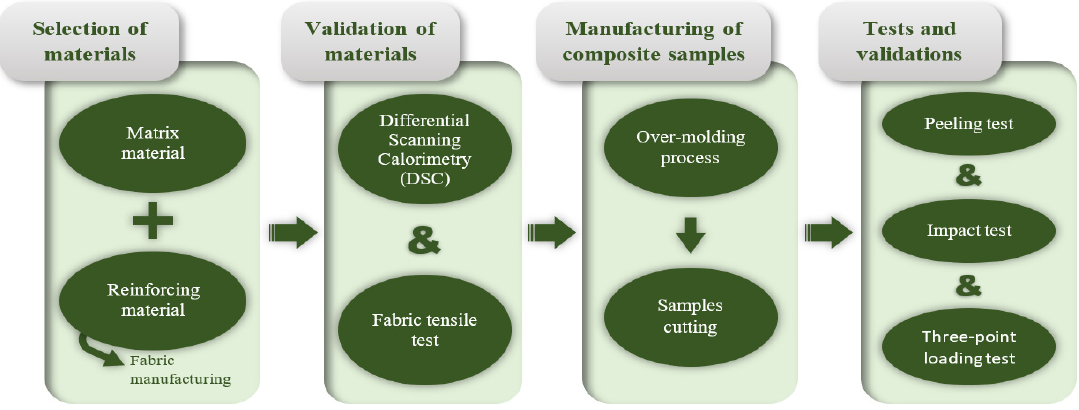
Figure 1. Experimental procedure.